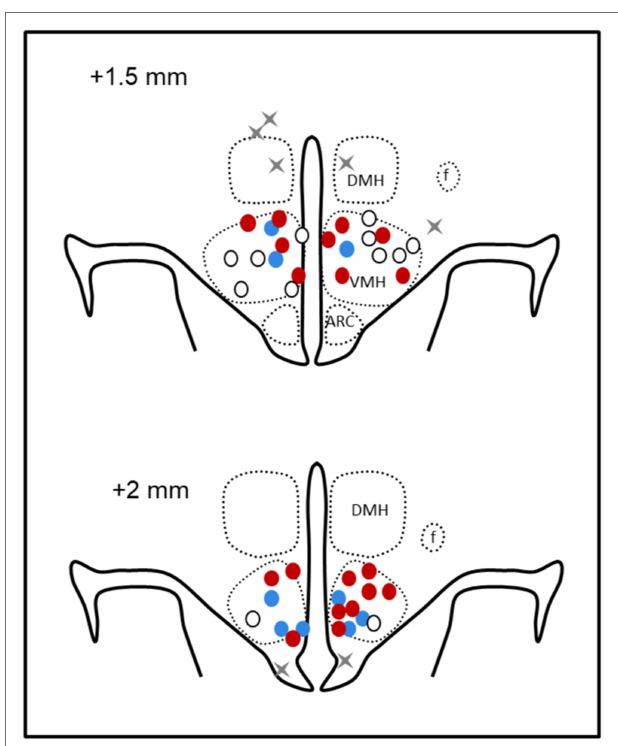
FIGURE 3 | Schematic representation of microinjection sites. Coronal sections at 1.5 mm and 2 mm posterior to bregma showing bilateral microinjection sites as circles in offspring of mCD (white), maternal HFD (red), and mCD with 10 days HFD (blue) when in the ventromedial hypothalamus and gray crosses when outside ( n = 4). DMH, dorsomedial hypothalamus; f, fornix; and arc, arcuate